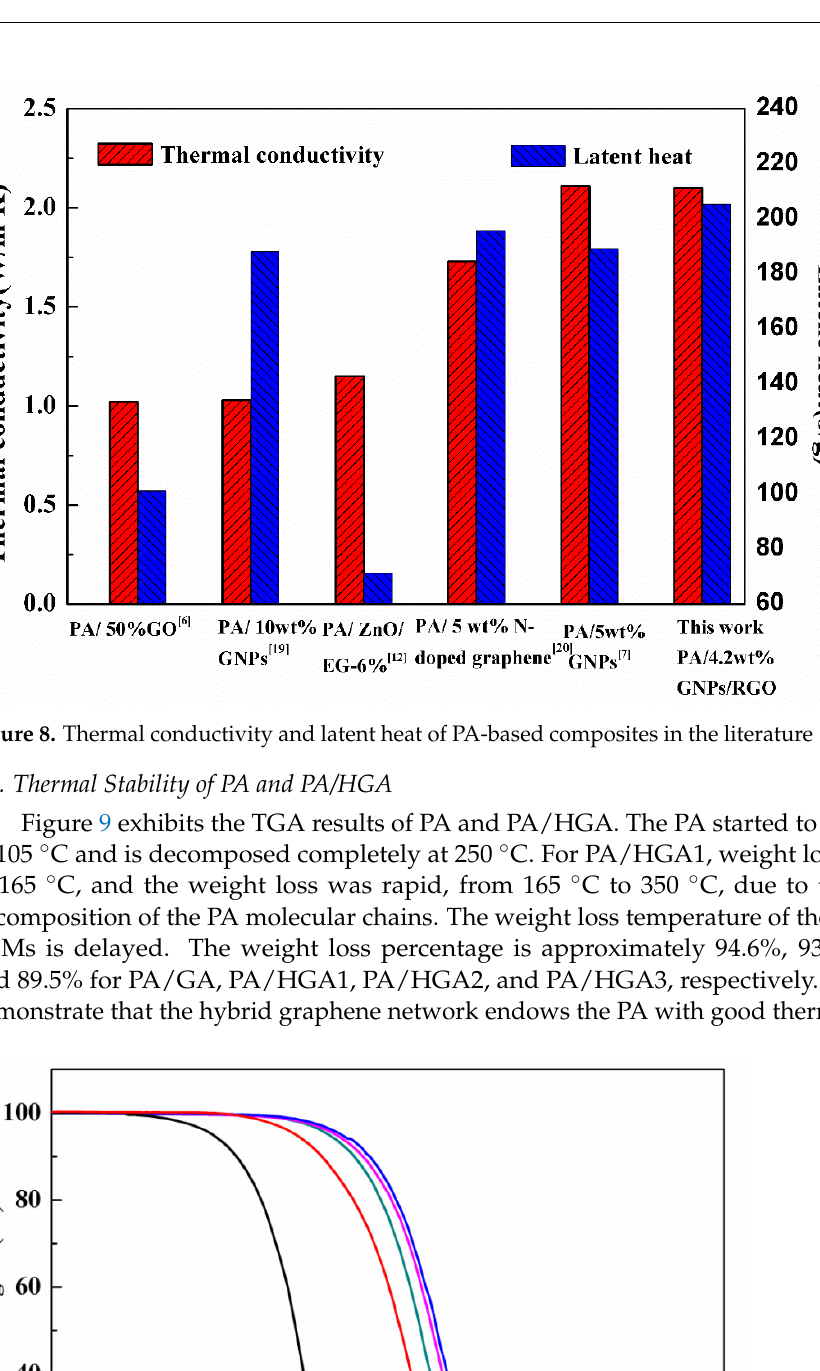
Figure 10. Photos of PA and PA/HGA heated at 80 °C for 0 min ( a ) and 30 min ( b ). Figure 11a exhibits the DSC curves of PA/HGA3 before and after 100 thermal cycles. The T m and T f values of PA/HGA3 change by −0.01 °C and 0.21 °C, respectively. The ΔH m and ΔH f values of PA/HGA3 are reduced by 1.2% and 2.3%. It can been seen from Figure 11b that the major peaks in the FT-IR spectra have no change. These results indicate that the composite PCMs have excellent thermal and chemical reliability.